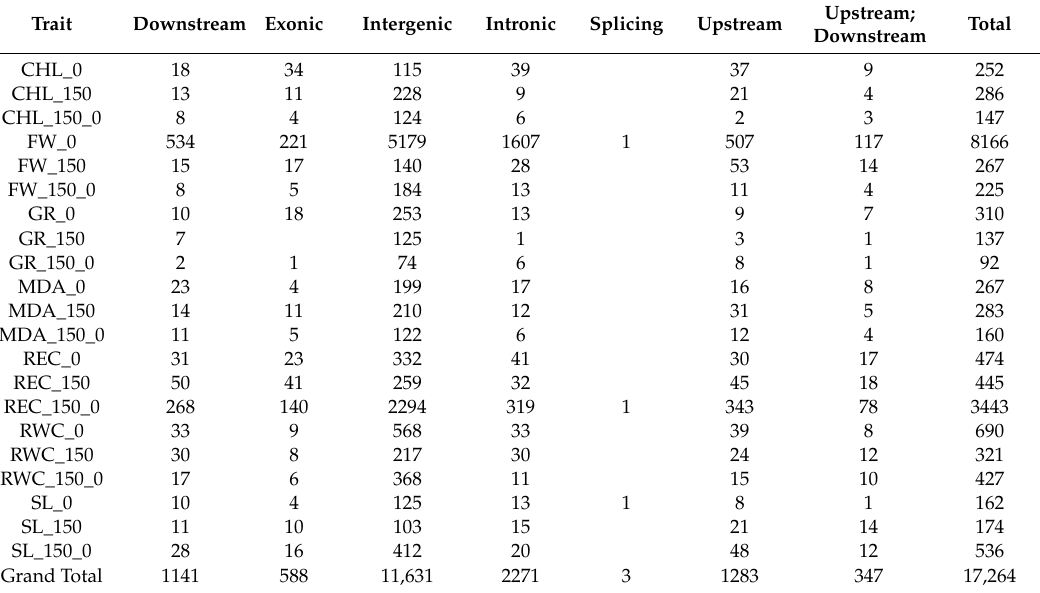
Table 3. Distribution of single-nucleotide polymorphisms (SNPs) on the gene regions. Trait Downstream Exonic Intergenic Intronic Splicing